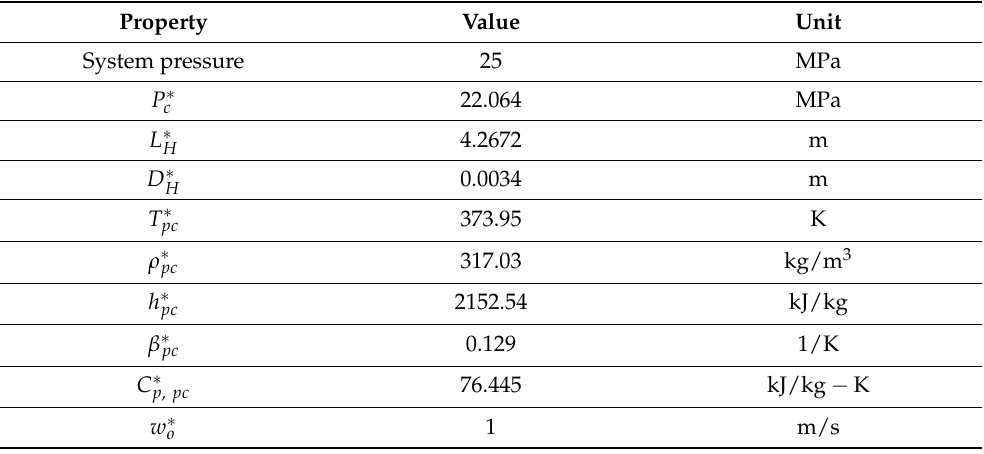
Table A1. The parametric values for the supercritical pressure channel